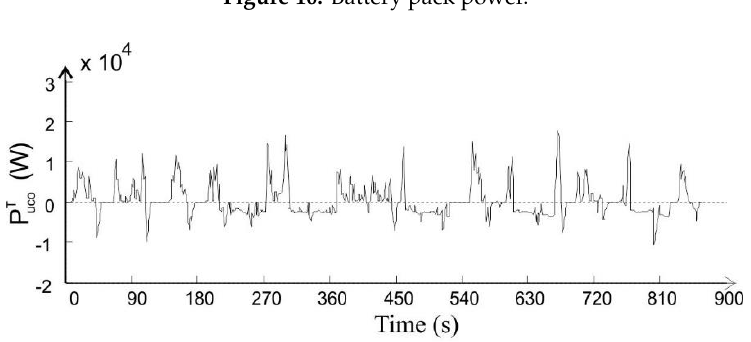
Figure 11. UC bank Figure 11. UC bank power. Figure 11. UC bank power.